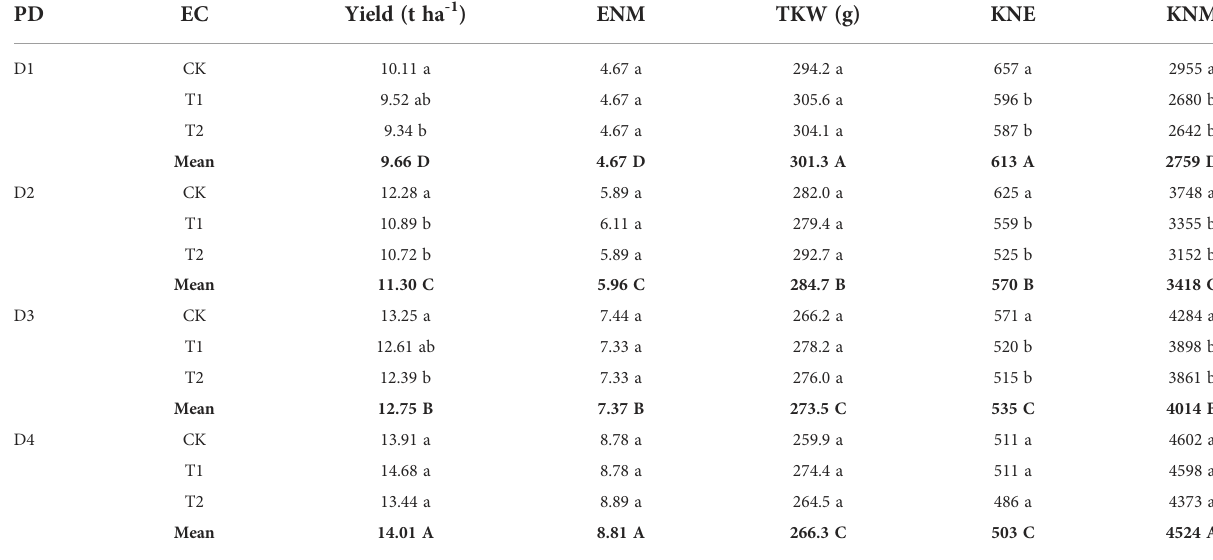
TABLE 2 Effects of plant growth regulator (EC) application and plant density (PD) on maize grain yield and yield components in 2021. PD EC Yield (t ha -1